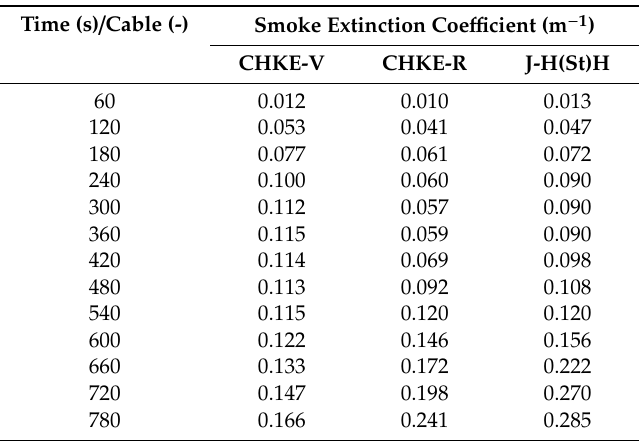
Table 5. Smoke extinction coe ffi cients for selected fire